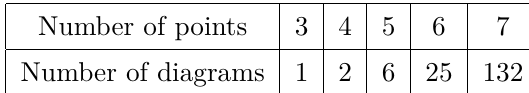
Table 1 . Number of diagrams needed to compute n -point exponential color-kinematics numerators. This composition matches the one explored at lower